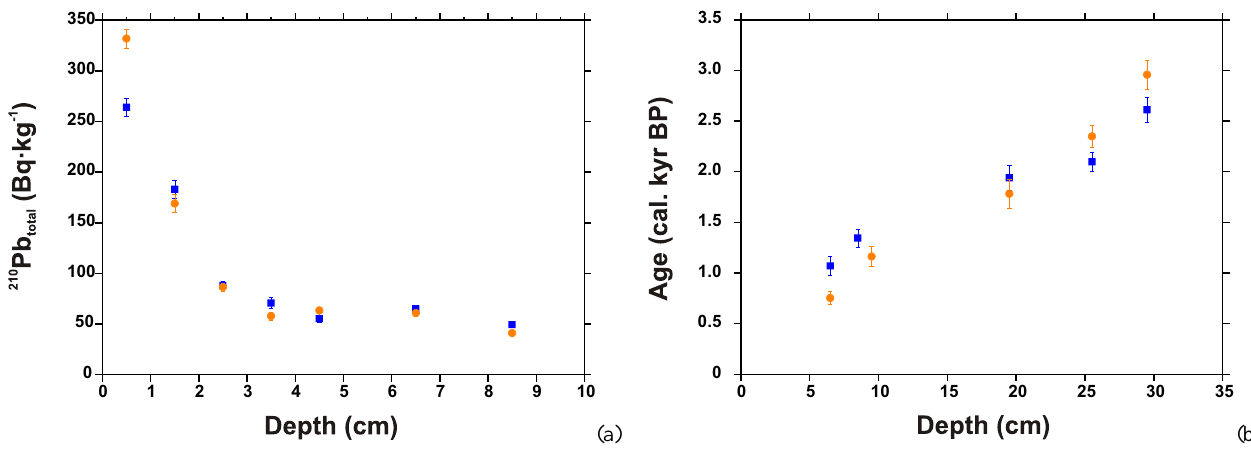
Fig. 2. Activity profiles of 210 Pb total (Bqkg − 1 ) for cores 305G (blue squares) and 306G (orange circles) with error bars representing 1 σ uncertainties (a) and 14 C dates for core 305G (blue squares) and 306G (orange circles) with error bars representing 2 σ uncertainties (b) .